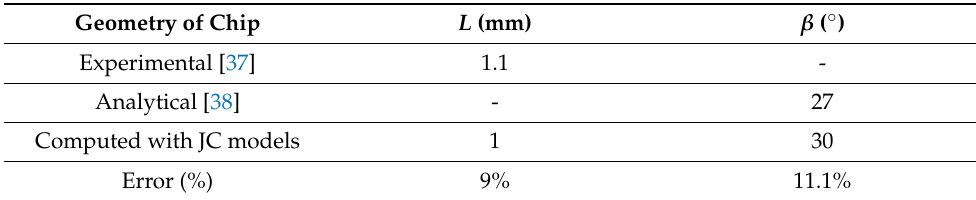
Table 11. Chip geometries, Vc = 50m/min.